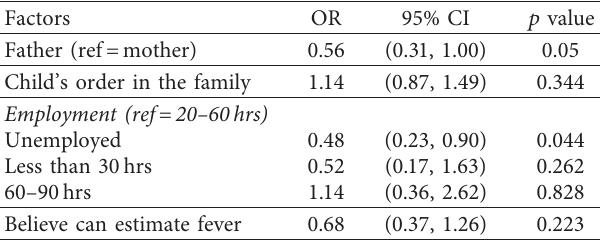
Table 4: Association between variables and identification of fever over 39 ° C by palpation ( n � 239).